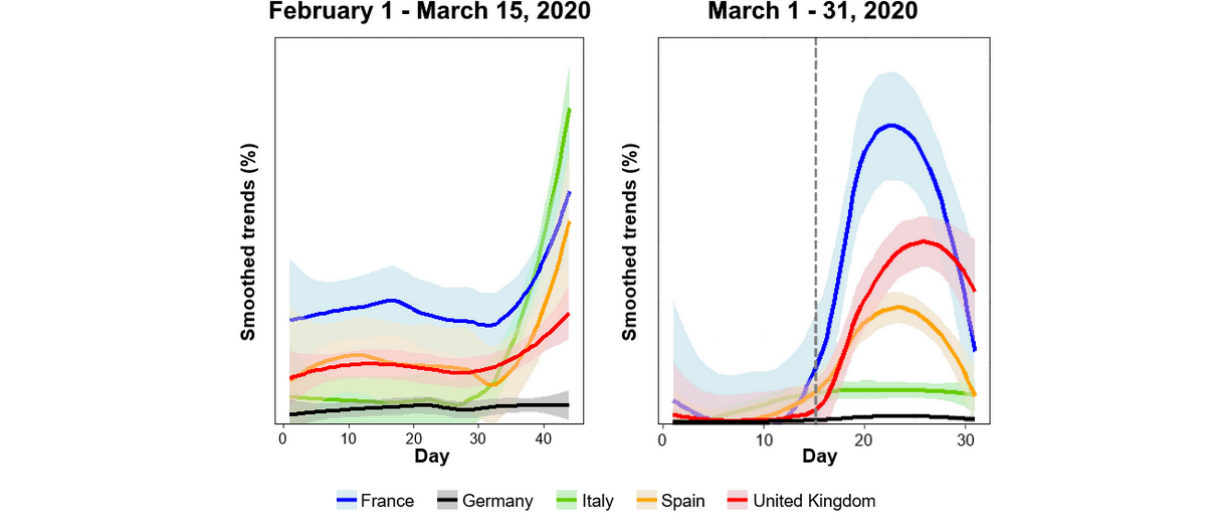
Figure 4. Average GT data for anosmia and ageusia before the media publicized that these terms can be symptoms of COVID-19 (February 1 to March 15, 2020) and in the 2 weeks before and after this media release (marked with a grey dashed line) (March 1 to 31, 2020). Data are presented on a daily basis as Loess-smoothed percentages of the maximum value and are adjusted for the population.